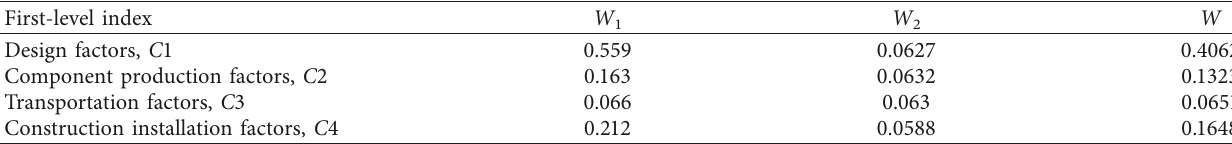
Table 11: Comprehensive weight of the first-level index.